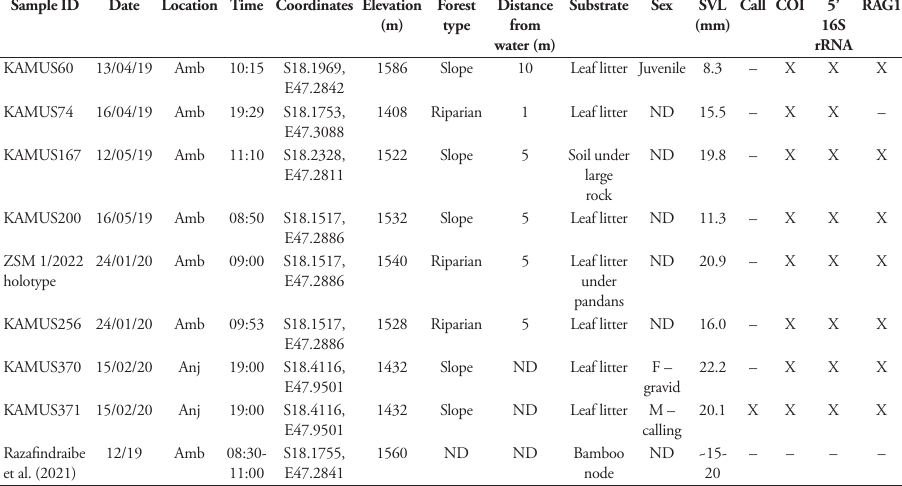
Table 1. Details of all Stumpffia lynnae sp. nov. samples from Ambohitantely (Amb) and Anjozorobe (Anj). ND: Not